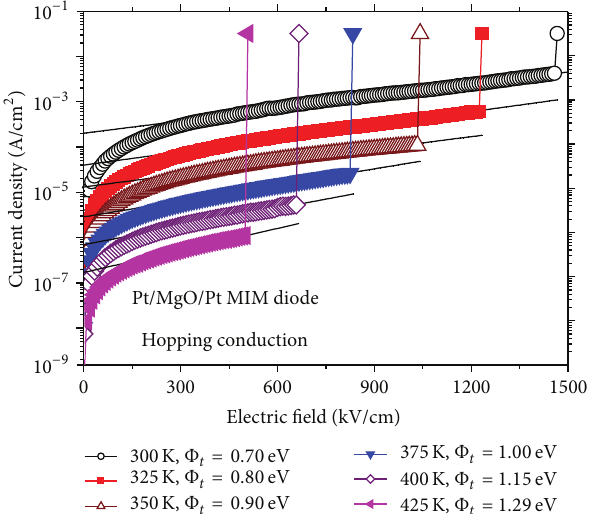
Figure 18: Experimental data and simulation curves of hopping conduction in high resistance state in Pt/MgO/Pt memory device.